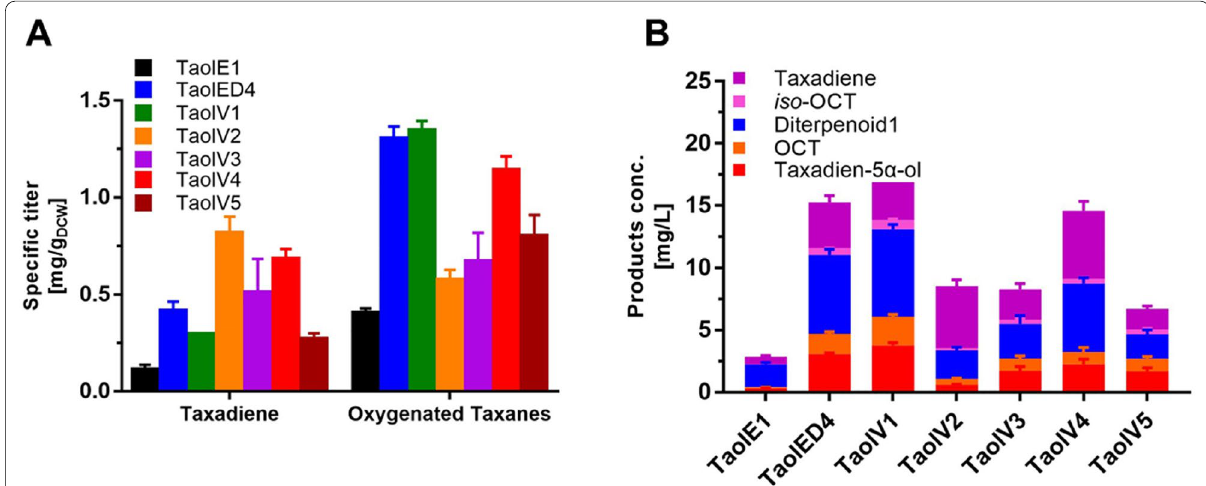
Fig. 4 Effects of different terpenoid precursor supply pathways on the yield of oxygenated taxanes. A Comparison of the specific titers of TaolV1‑5 strains; B comparison of the product concentrations of TaolV1‑5 strains with those of TaolE1 and TaolED4